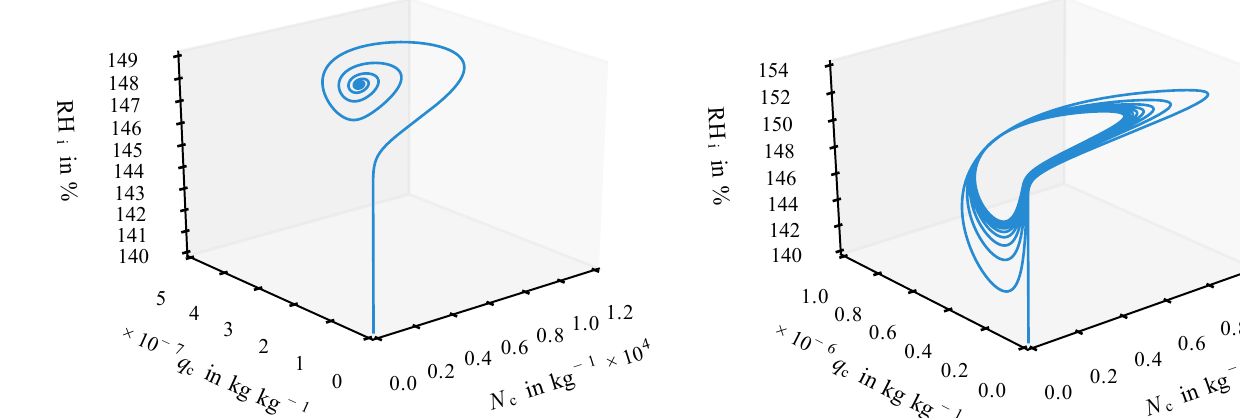
Figure 6. Limit cycle for state 2: orbit in phase space at T = 210K, w = 0 . 02ms − 1 . Note that the solution starts “outside” of the limit cycle and approaches the limit cycle attractor asymptotically.